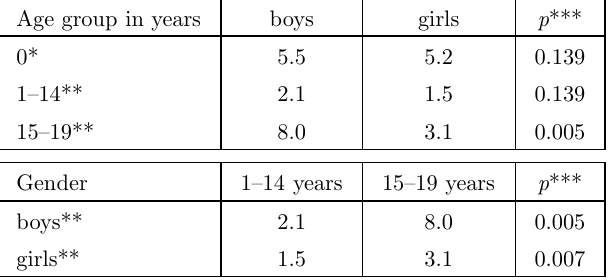
Table 1. Median of the overall mortality rate among children and adolescents by age and sex in the Podlaskie Voivodeship in the years 2003–2012 Age group in years boys